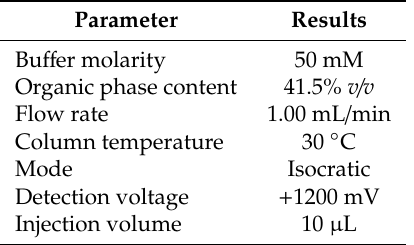
Table 3. Optimized chromatographic conditions for the overall separation of CLA and